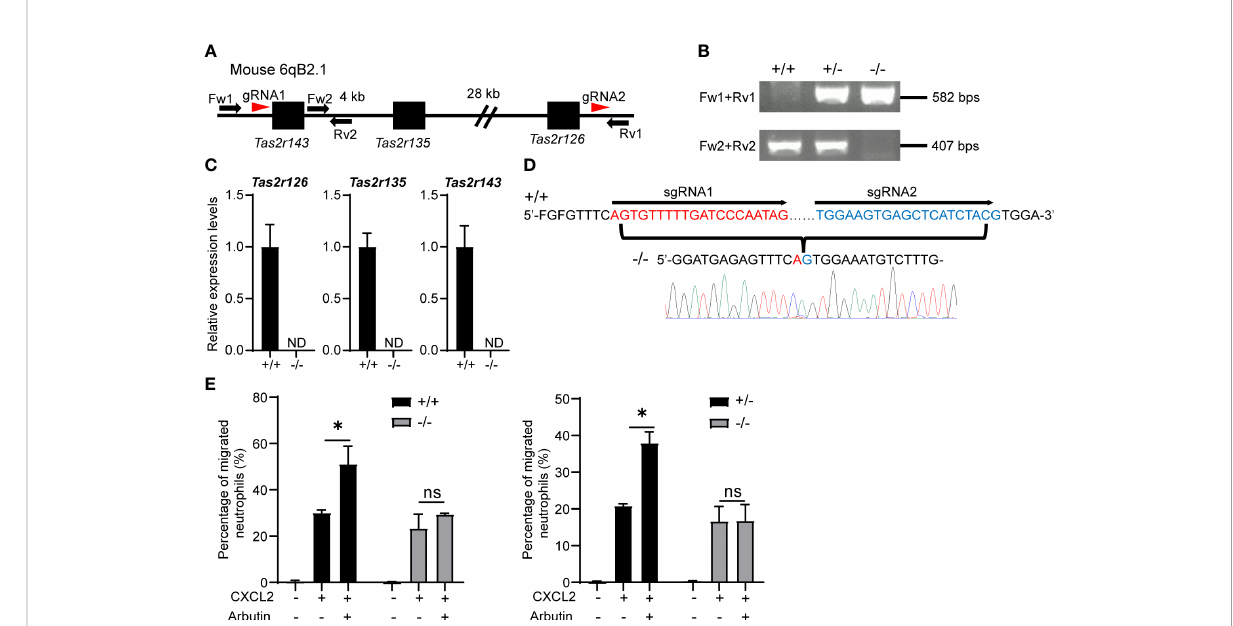
FIGURE 4 Arbutin-mediated enhancement of CXCL2-stimulated neutrophil migration is attenuated by deletion of Tas2r126, Tas2r135 , and Tas2r143 . (A) Schematic showing the location of Tas2r126, Tas2r135 , and Tas2r143 genes on mouse chromosome 6qB2.1 and the position of gRNAs designed for deletion of the gene cluster between Tas2r143 and Tas2r126 (red arrowheads). Fw1, Fw2, Rv1, and Rv2 indicate the primers used for PCR genotyping of the mice. (B) DNA fragments ampli fi ed from Tas2r126/135/143 +/+ , +/ − , and − / − mice. (C) RT-qPCR analysis of Tas2r126 , Tas2r135 , and Tas2r143 mRNA expression levels in bone marrow (BM)-derived neutrophils from Tas2r126/135/143 +/+ or − / − mice. Data are presented as the mean ± SD of triplicates from one experiment and are representative of three independent experiments. ND, not detected. (D) DNA sequences of PCR amplicons. A total of 35 kb of the genomic region between Tas2r143 and Tas2r126 was deleted in the Tas2r126/135/ 143 − / − mice. (E) Transwell migration assays of BM-derived neutrophils from Tas2r126/135/143 +/+ and − / − mice (left panel) or +/ − and − / − mice (right panel). Cells were pretreated with 90 mM arbutin for 30 min and then stimulated with 20 ng/ml CXCL2. Data are presented as the mean ± SD of triplicates from one experiment and are representative of three independent experiments. * p < 0.05 by Student ’ s t test. ns, not signi fi